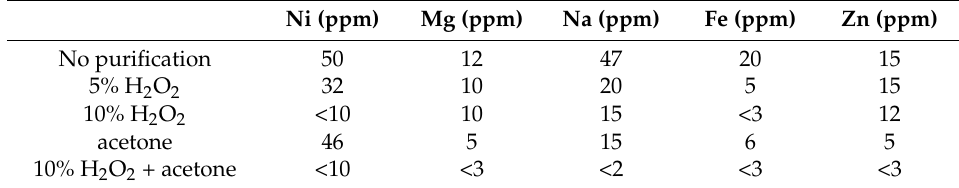
Table 9. Impurity contents after